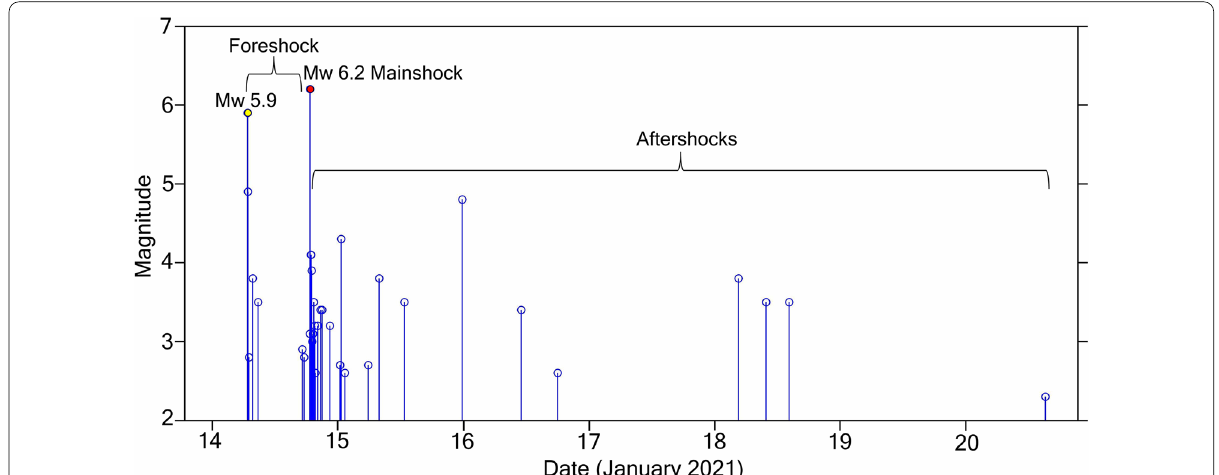
Fig. 2 Magnitude vs time for foreshocks, mainshock, and aftershocks of Mamuju–Majene earthquake. The detection threshold of our analysis is M